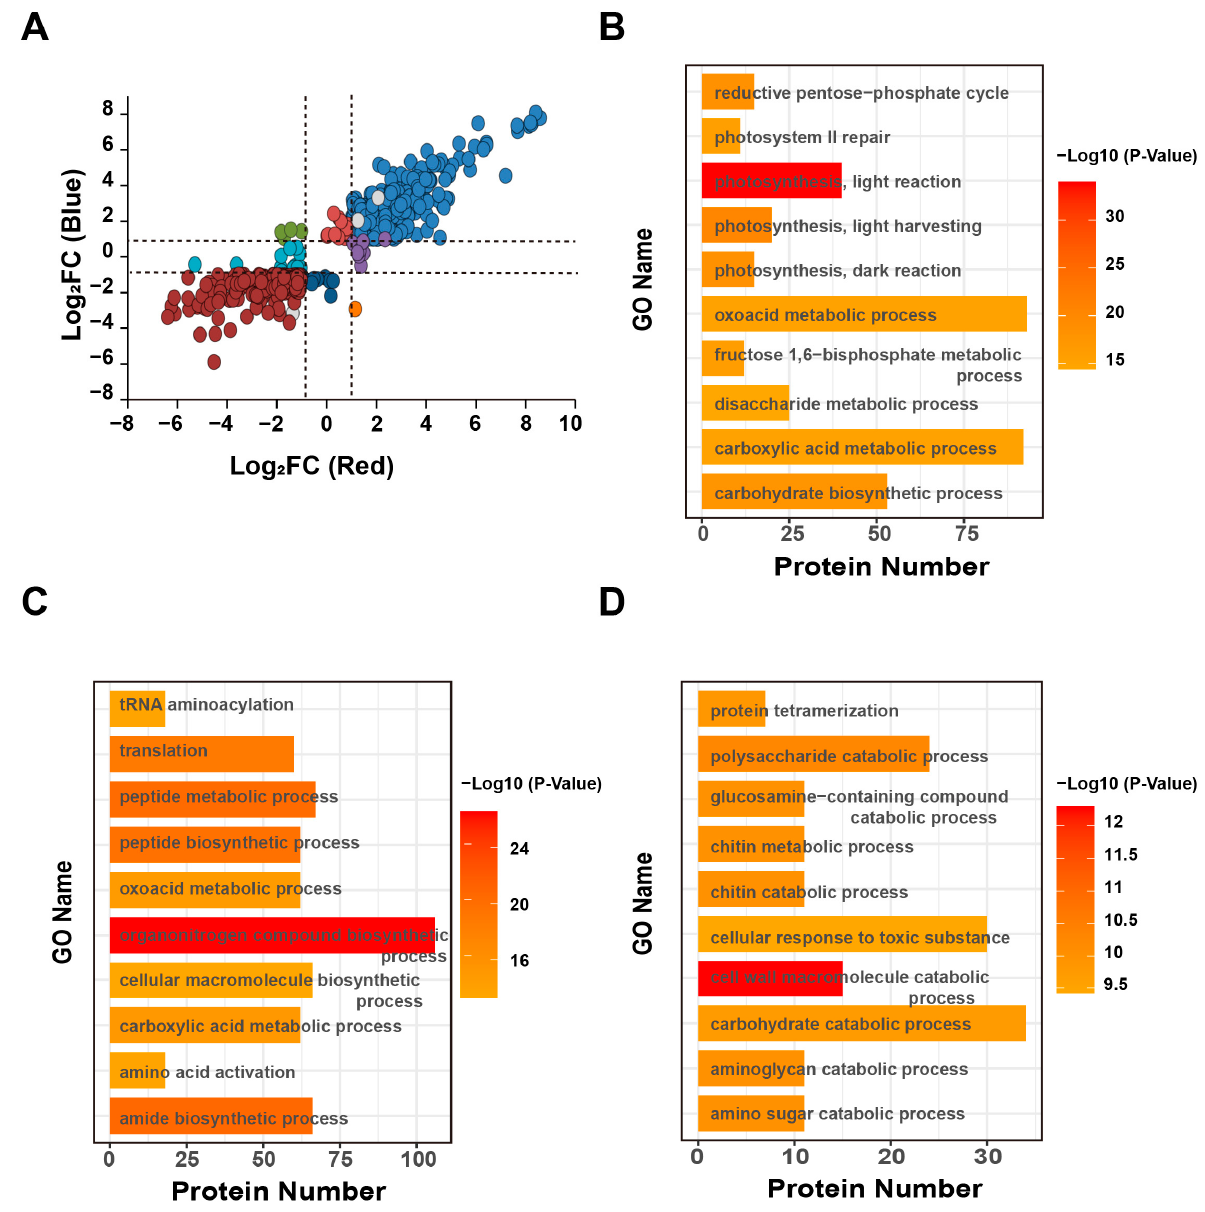
Figure 4. Differences in protein expression in moso bamboo under red and blue light treatments. ( A ) Scatter plot showing the association between the blue light-responsive proteins and the red light-responsive proteins in moso bamboo. The dashed lines indicate Log2 (FC) = ±1. The steel blue and dark red plots indicated the co-upregulated/downregulated proteins under red and blue light treatments. Green and orange plots indicated the proteins regulated in the opposite direction between red and blue light treatments. Red and navy plots indicated the proteins upregulated/downregulated under blue light and unchanged under red light. Purple and cyan plots indicated the proteins upregulated/downregulated under red light and unchanged under blue light. Gray plots indicated the proteins with p value > 0.01. ( B ) GO enrichment analysis of the blue and red light co-responsive proteins shown in ( A ). ( C ) GO enrichment analysis of the blue light-specific responsive proteins shown in ( A ). ( D ) GO enrichment analysis of the red light-specific responsive proteins shown in ( A